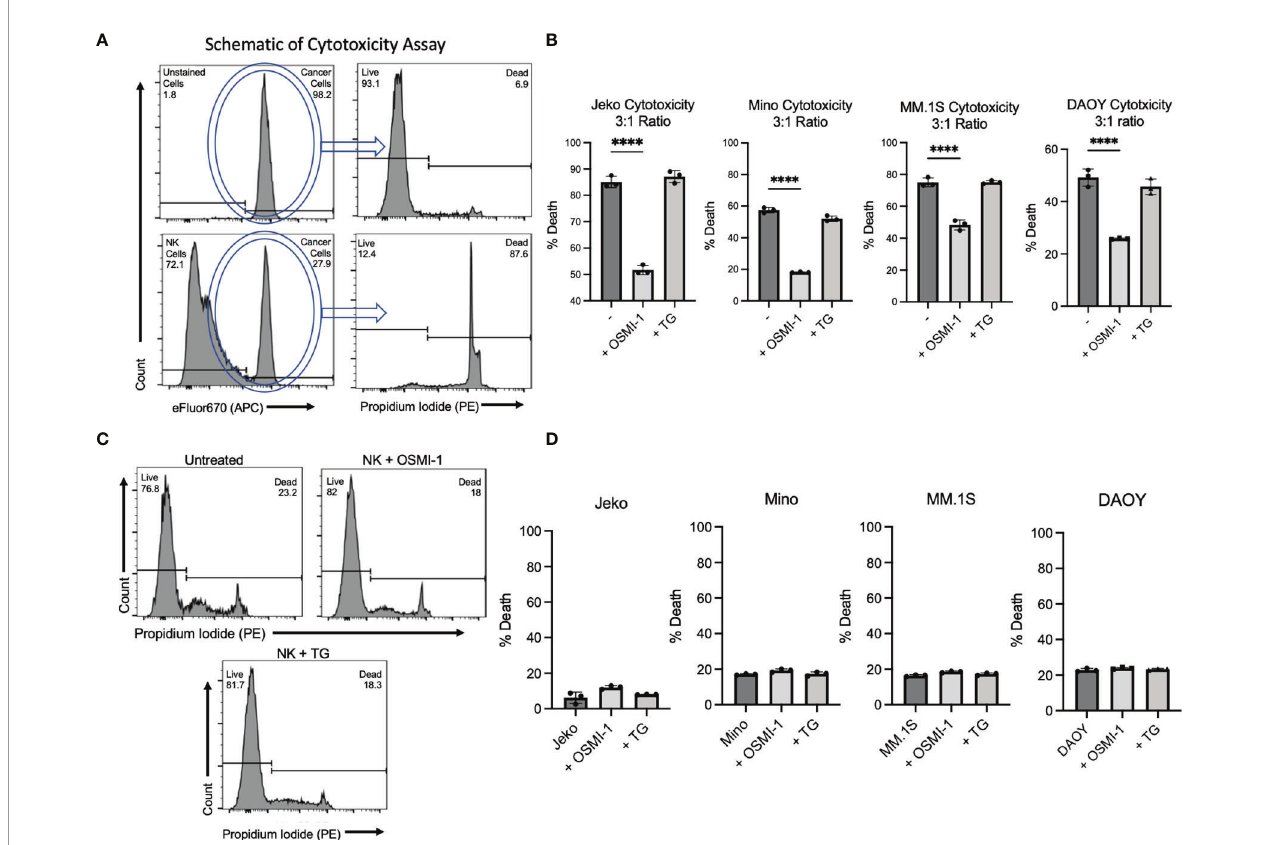
FIGURE 3 | OSMI-1 (25 µM) treatment inhibits primary NK and NK92 cytotoxicity in vitro , while TG (50 µM) has no effect on cytotoxicity. Panel (A) shows schematic of fl ow cytometry gating strategy with e fl uor670-labeled cancer cells visible in APC channel and subsequent gating of PI stain peak. The top two panels show Jeko cells without NK cells present take up high rates of the dye and are largely viable. The bottom two panels show that the APC channel can distinguish between stained Jeko cells and unstained NK cells, and in the presence of NK cells, a far greater number of Jeko cells are dead. Panel (B) shows cytotoxicity of primary NK cells pretreated for 24 h with OSMI-1 (25 µM) and TG (50 µM) before being coincubated with Jeko, Mino, and MM.1S cells for 12 h and DAOY for 4 h with OSMI-1 (25 µM) and TG (50 µM) still present. Panel (C) shows Jeko, Mino, and MM.1S cell death as a result of OSMI-1 (25 µM) and TG (50 µM) treatment for 24h and DAOY at 12 h. Panel (D) shows viability of NK cells after 48 h of culture with OSMI-1 (25 µM) and TG (50 µM). Statistical analysis determined via one-way ANOVA with Dunnett ’ s multiple comparisons to the untreated (-) NK group mean. **** indicates signi fi cance of p <.0001. Error bars are standard deviation of the mean. Experiments shown in 1C, as well as those done on Jeko, Mino, and MM.1S cells in 1B and 1D were performed three times. Experiments performed on DAOY cells were done twice. All three individual data points displayed are individual cellular cultures or cocultures of cytotoxicity experiments. Experiments shown are representative of 2 or 3 experiments performed as indicated